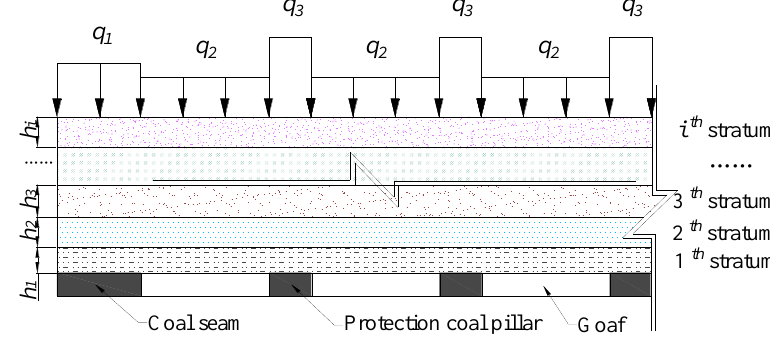
Figure 5. Applied forces on the basic environment in a stope.